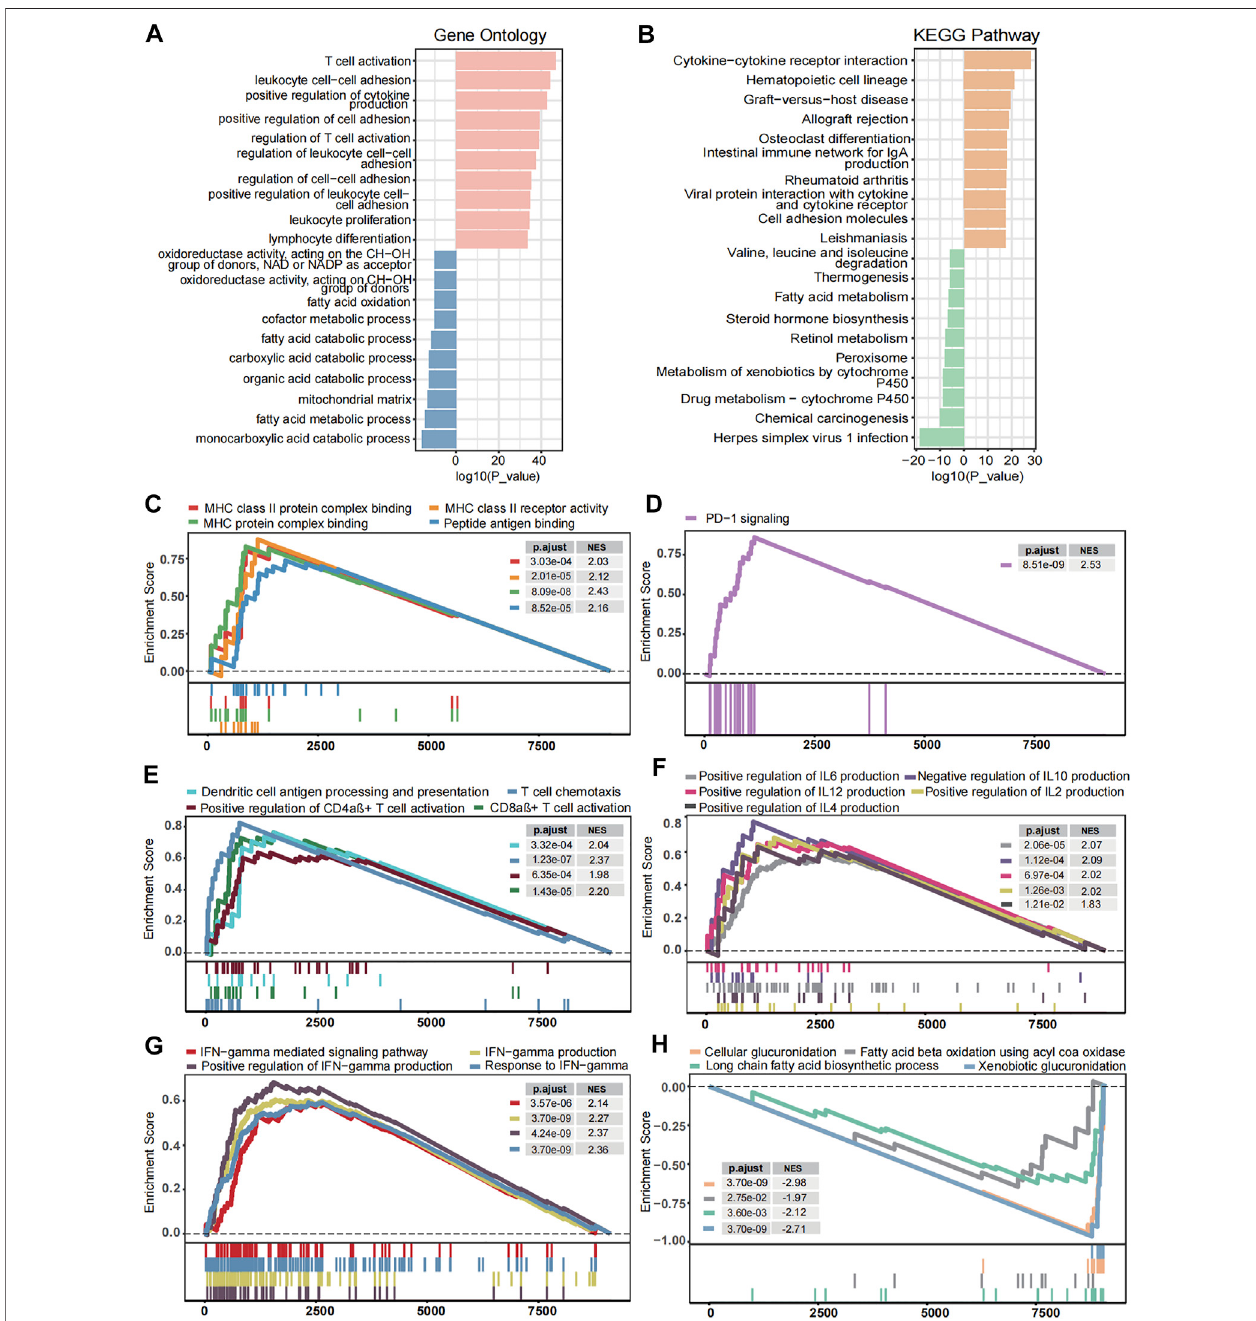
FIGURE5 | Transcriptometraitsrelated toMHC-II signature in the ICI-cohort. (A,B) .Gene Ontology enrichment (A) and KEGG enrichment analyses (B) show that gene sets up-regulated in MHC-H tumors were enriched in the immune activation process, while those overexpressed in MHC-L tumors were enriched in fatty acid metabolismandsteroidhormonebiosynthesis.Thetoptengenespersetareshown(rankedbysingle-gene p value,GO:red:high,blue:low;KEGG:orange:high,green: low). (C – H) The GSEA analysis shows the key pathways of enrichment in the MHC-H (up) and MHC-L (down) groups. Antigen processing and presentation (C) , PD − 1signaling (D) ,immunecellactivation (E) ,cytokineproduction (F) ,andIFN − gamma (G) relatedpathwaysweresigni fi cantlyup-regulatedintheMHC-Hgroup,while fatty acid metabolism and glucuronidation (H) were signi fi cantly up-regulated in the MHC-L group. The x -axis represents the ranking of genes in the rank lists.